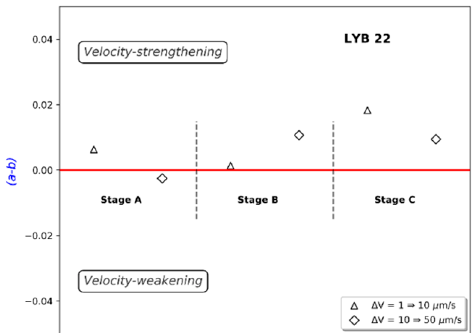
Figure 13. Friction rate parameter ( a − b ) for Rurikfjellet specimen (LYB22). Positive values show velocity-strengthening and thus imply aseismic slip and negative values show velocity-weakening and seismic slip.